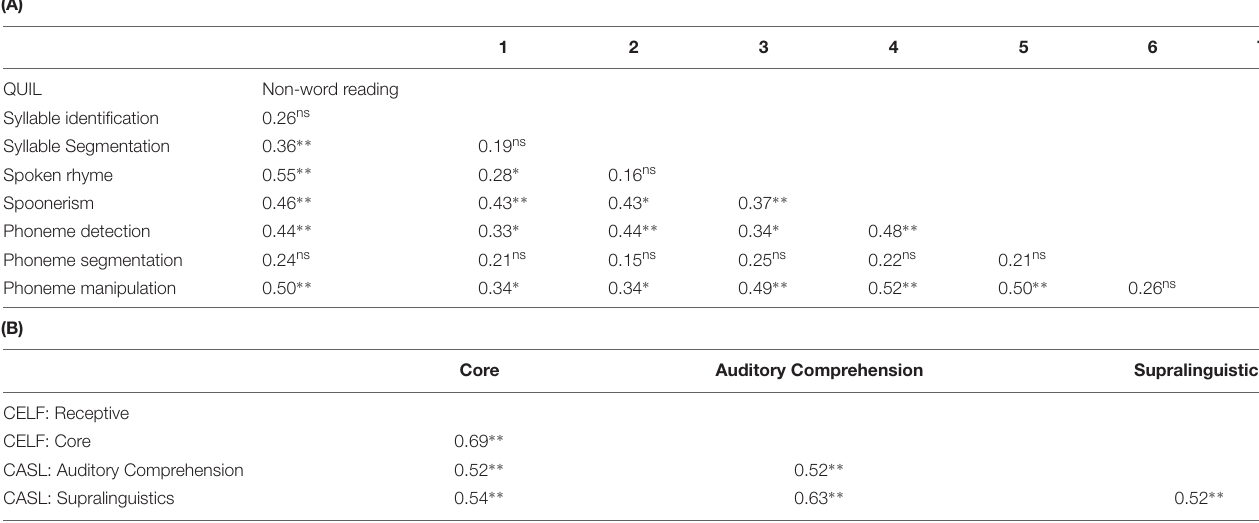
TABLE 2 | Pearson correlations.